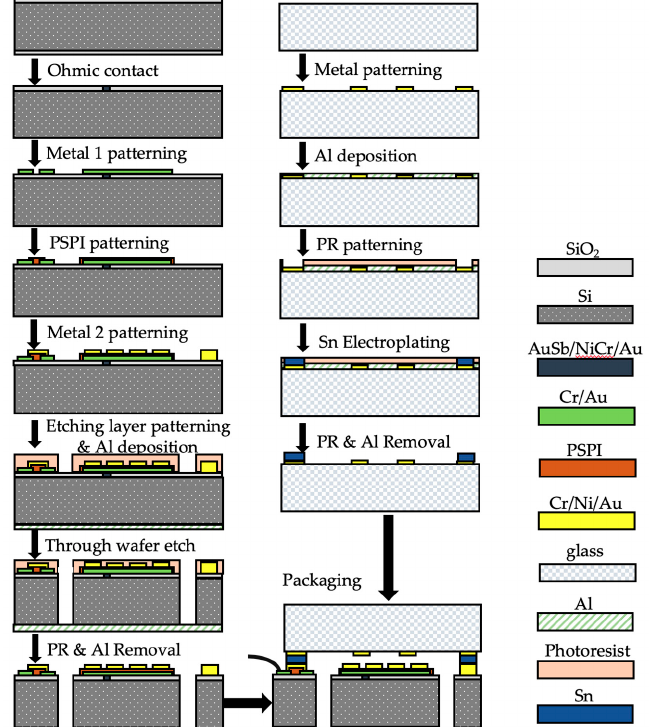
Figure 6. The microfabrication process flow of the proposed MEMS accelerometer.